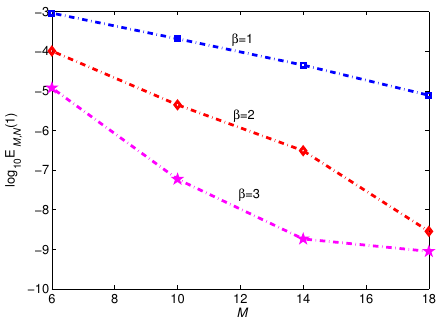
Figure 2. log 10 E M,N (1) vs M of scheme (3.5) for (3.2) with different β